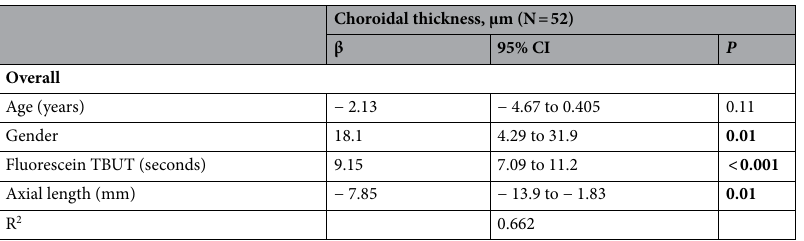
Table 6. Results of multiple regression analyses to estimate the association between choroidal thickness and dry eye disease. A multiple regression model was used. Choroidal thickness was used as the outcome variable. P < 0.05 are highlighted. For gender, boys were numbered 1 and girls were numbered 0. β coefficient, 95% CI 95% confidence interval, TBUT tear film breakup time.